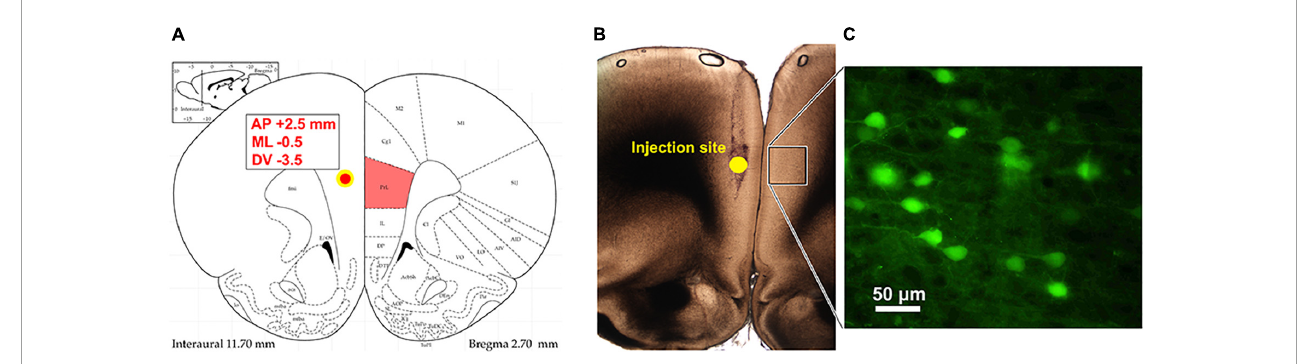
FIGURE1 Identification of commissural PLC neurons using retrograde viral tracing. (A) Injection site of retrograde pAAV-hsyn-EGFP into the PLC ipsilateral to the peripheral injury. Stereotaxic coordinates to target the left prelimbic cortex were AP: +2.5 mm from bregma; ML: –0.5; DV: 3.5 mm ventral to the surface. (B) Photograph of the injection site and the tract left from Hamilton syringe. The box represents the contralateral cortex where GFP expression was detected. (C) Retrograde AAV-mediated EGFP expression in PLC neurons in the hemisphere contralateral to virus injection.